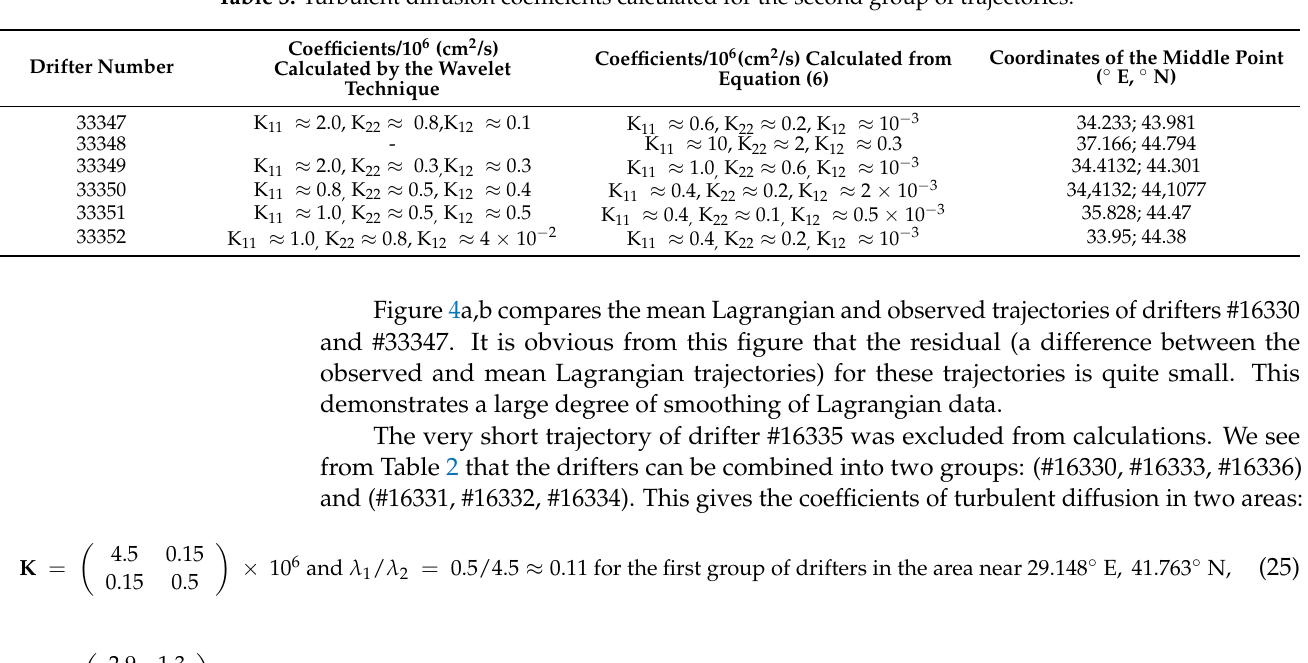
Table 3. Turbulent diffusion coefficients calculated for the second group of trajectories. Coefficients/10 6 (cm 2 /s) Coefficients/10 6 (cm 2 /s) Calculated from Drifter Number Calculated by the Wavelet Equation (6) Technique